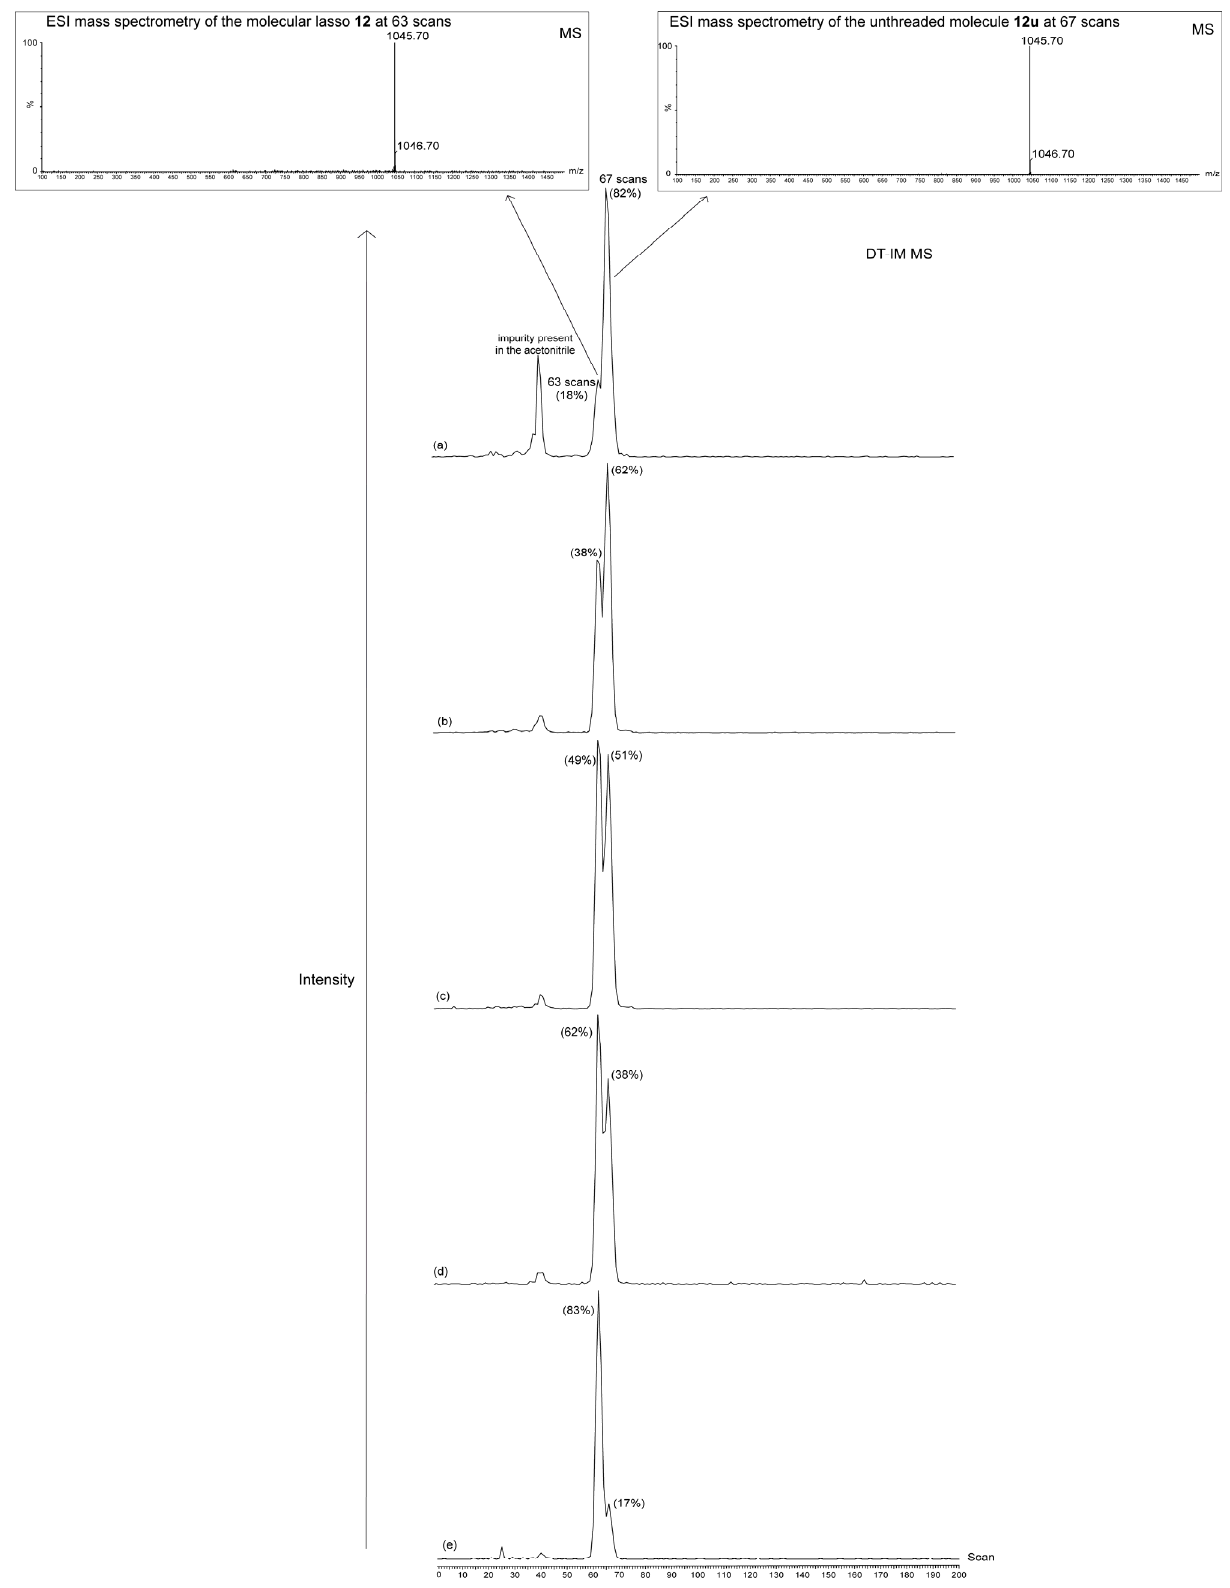
CN/CH Cl 10/90. ( e ) CH 3 2 2 ] + 6